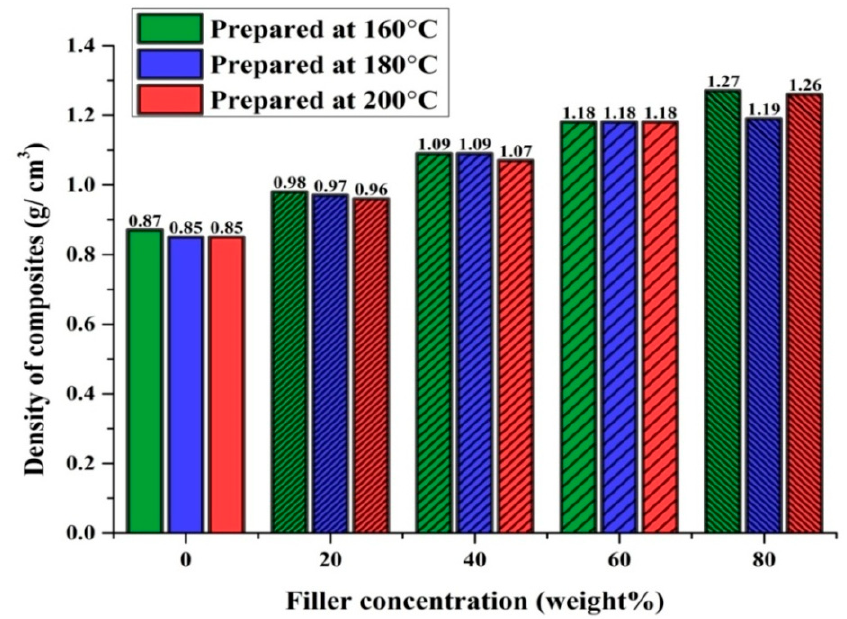
Figure 5. The density of MP-polypropylene (PP) composites / PP.